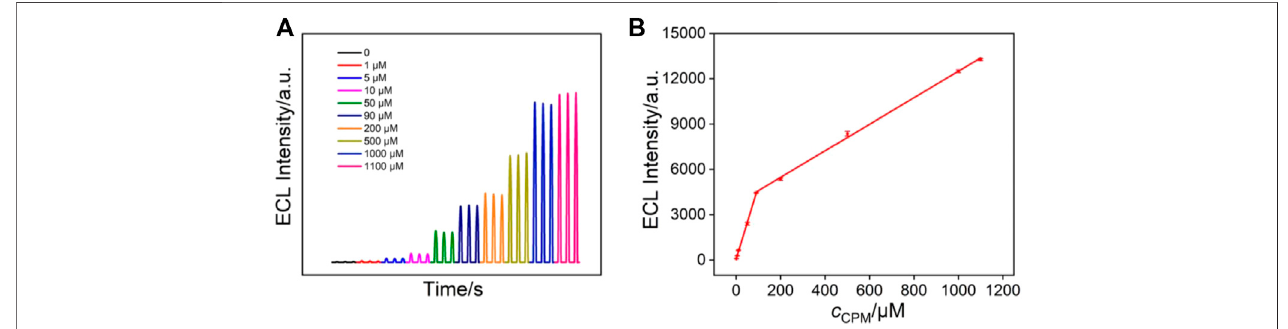
Frontiers in Chemistry |